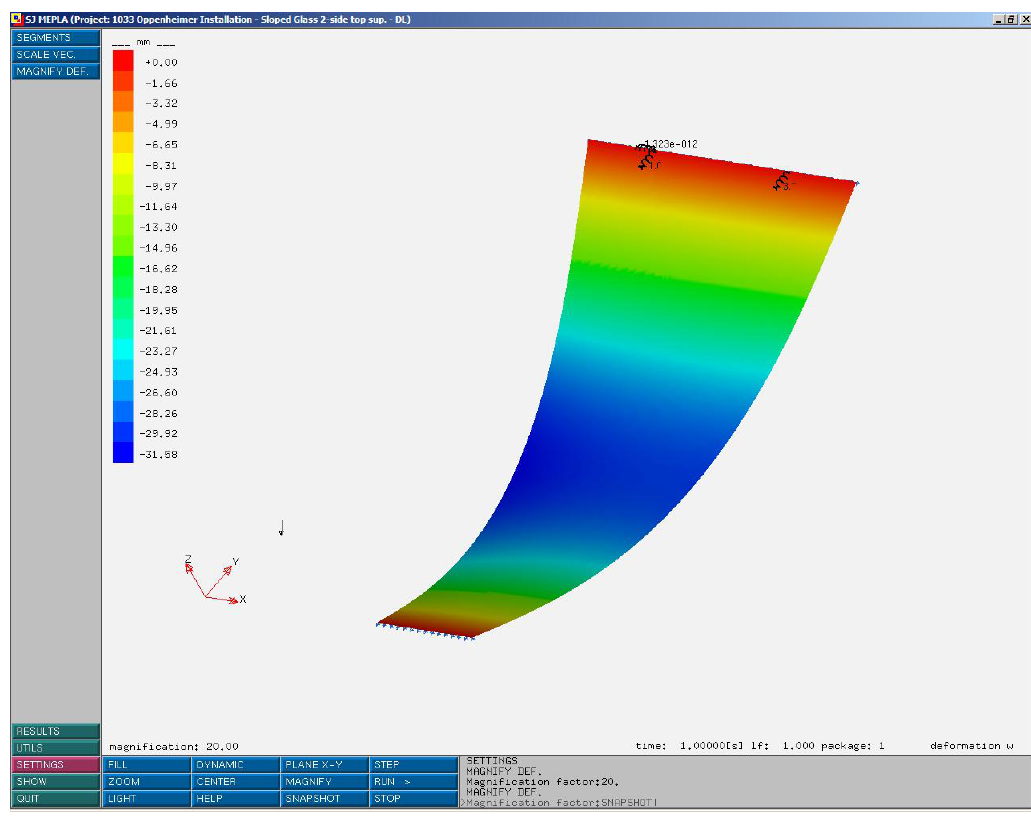
Fig. 6 P-131317, 2011 | Glass deflection study, 2-side simple supports